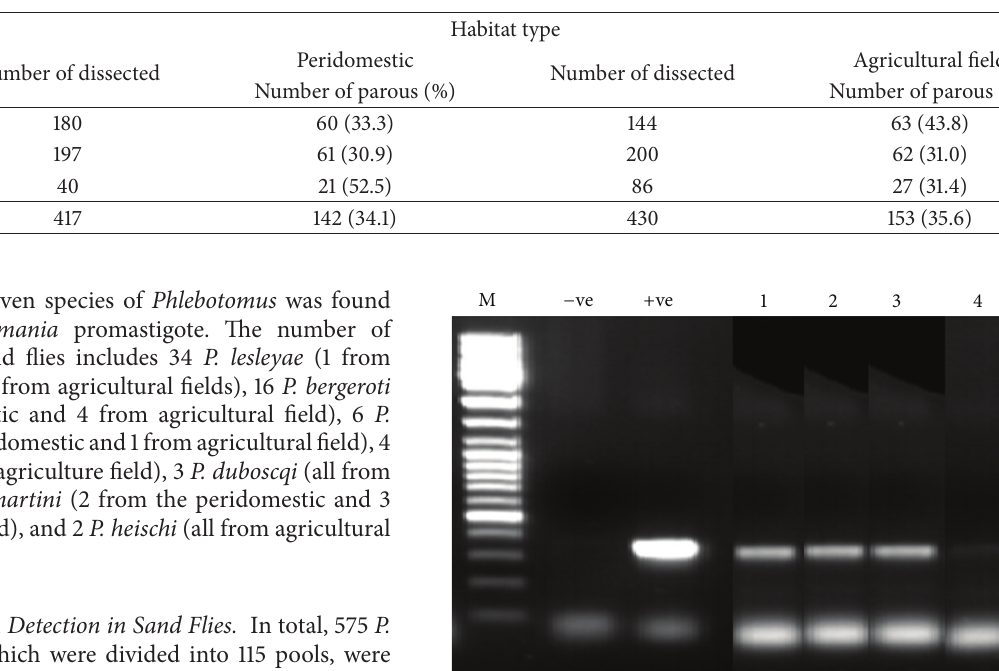
Table 3: Parous rates of P . orientalis females trapped using CDC light traps, May 2011 to April 2012.